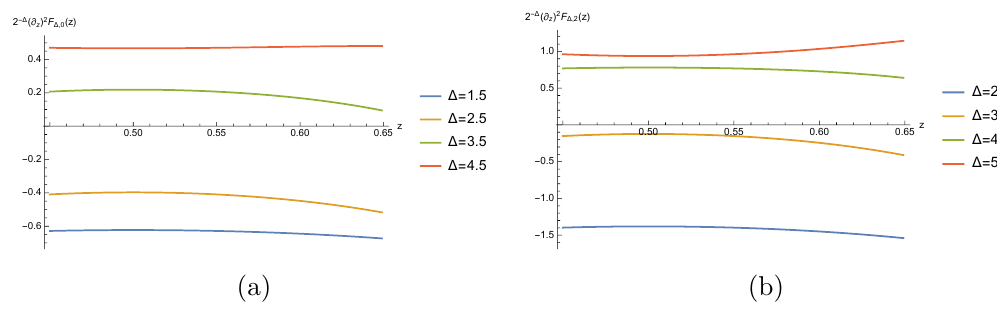
Figure 2. Plot of @ 2 F d; (cid:1) ;‘ ( z ) as a function of z for (cid:1) (cid:30) = 0 : 75 in d = 2. For ‘ (cid:21) 4 for z